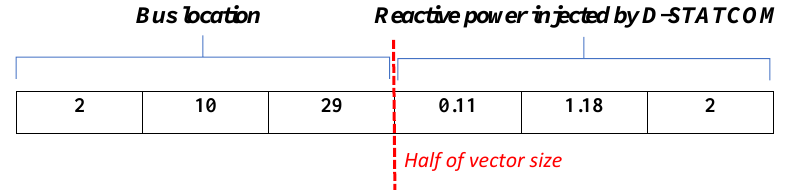
Figure 1. Proposed Discrete-Continuous codification. Algorithm 1: Pseudo-code for the DCPSO algorithm Data: Read EDS data and optimization